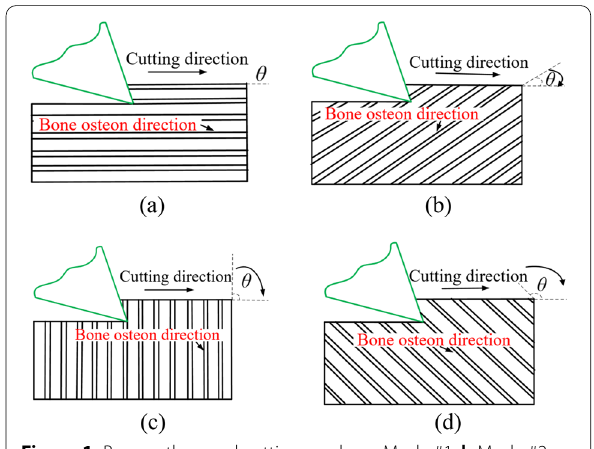
Figure 1 Bone orthogonal cutting modes: a Mode #1, b Mode #2, c Mode #3, and d Mode